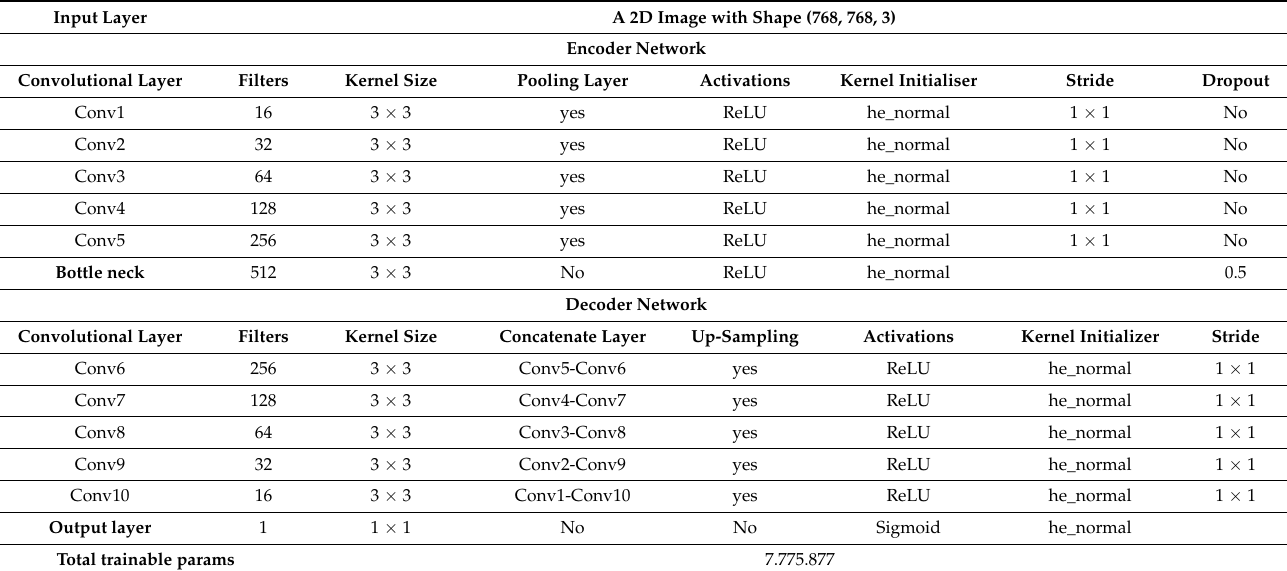
Table 3. Convolutional layers description for U-Net architecture.